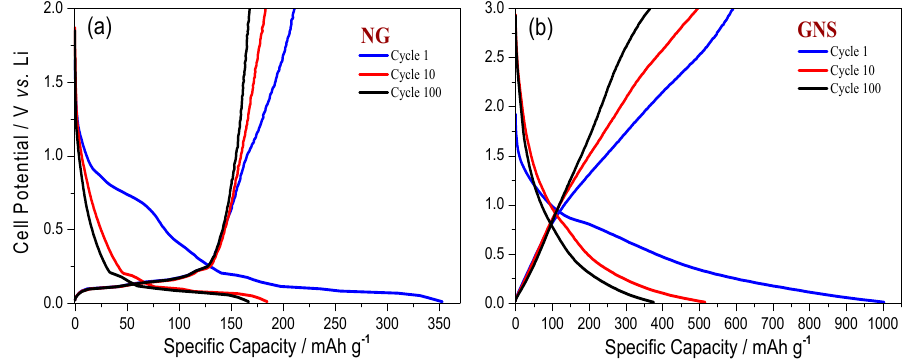
Figure 5. Discharge/charge curves for NG ( a ) and GNS electrodes ( b ) at a rate of C/5.